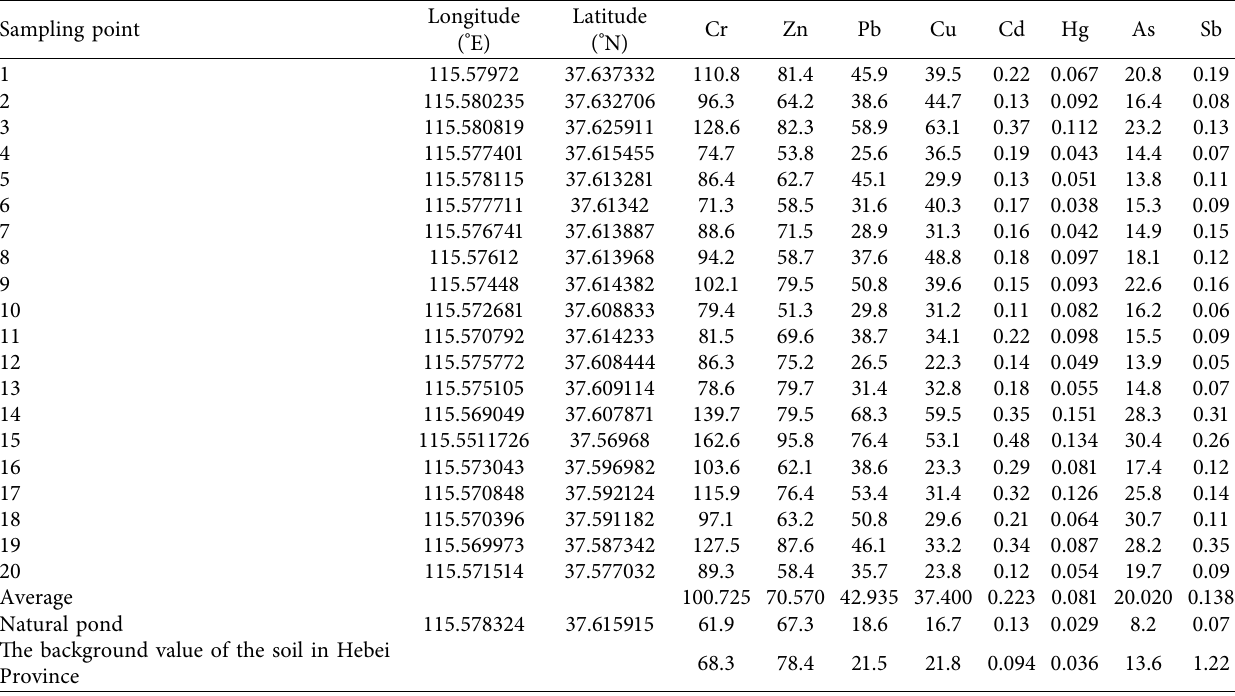
Table 2: Contents of heavy metal elements in the sediment at various sampling points in the West Lake of Hengshui Lake (mg/kg). Sampling